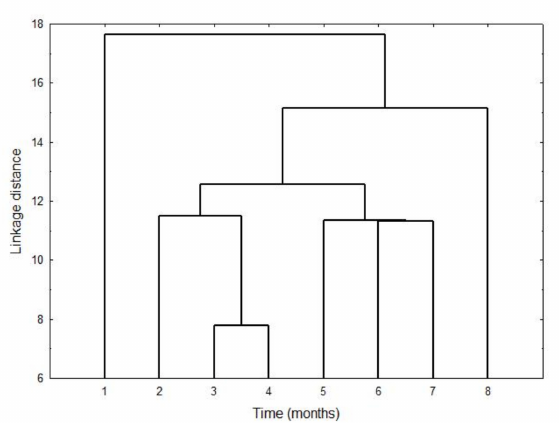
Figure 4. Cluster analysis of the VOO samples characterized by 15 phenols. Cluster of the full standardized data was implemented with City-Block (Manhattan) distance measure and the single linkage amalgamation